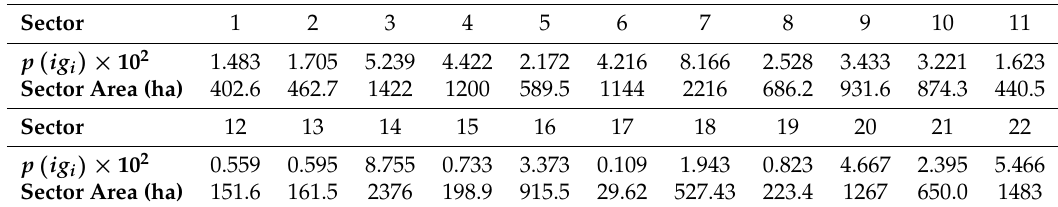
Table 2. Ignition probability and area considered for each